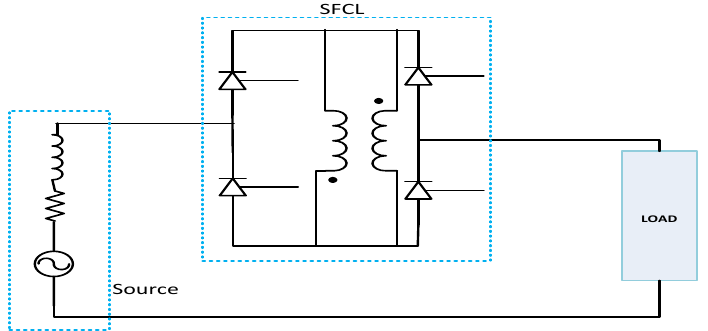
Figure 2. Basic circuit diagram of non-inductive superconducting fault current limiter (SFCL) with single phase circuit.